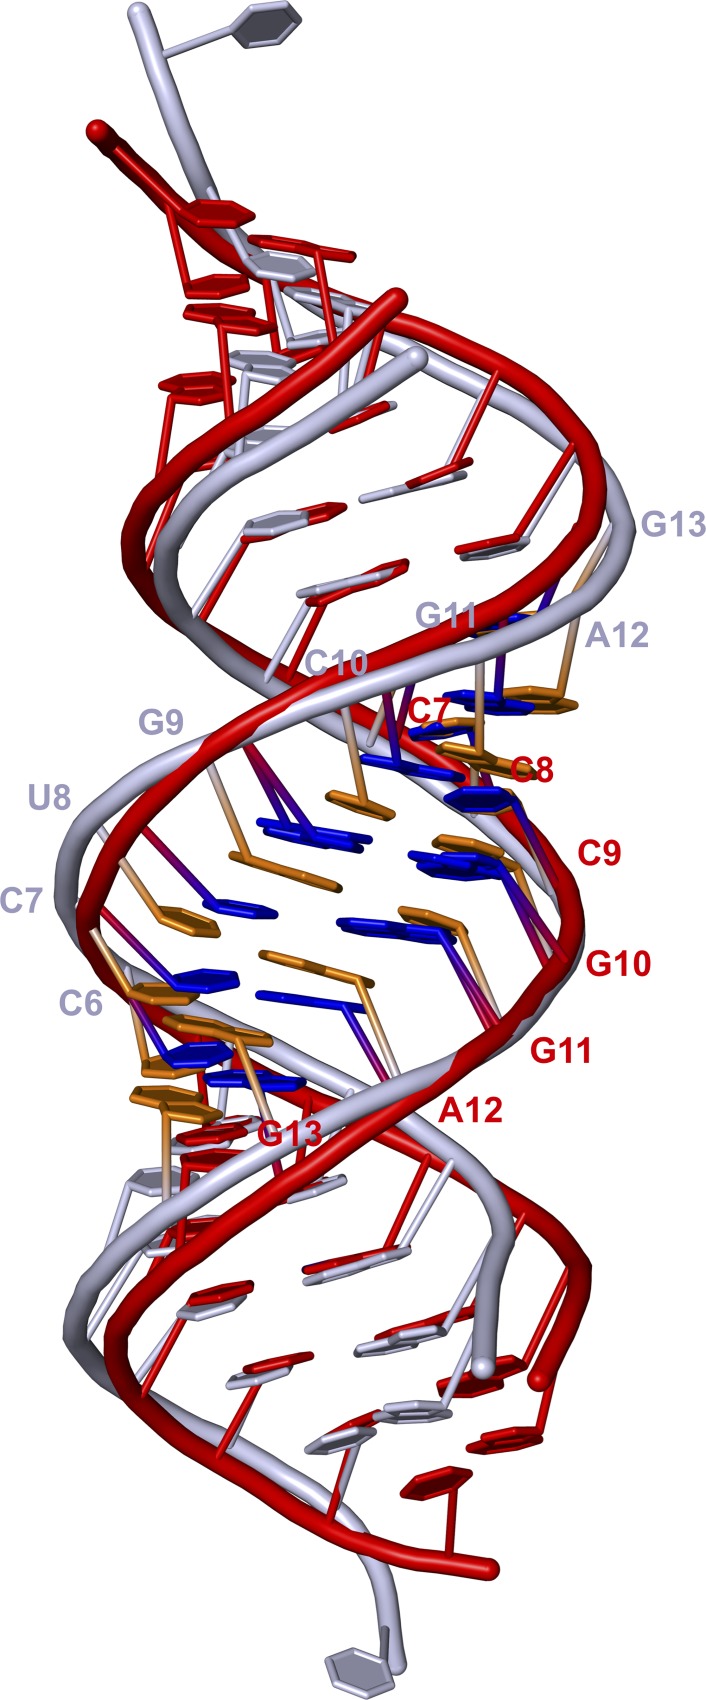
Superposition of the RNA II and 1KFO structures.RNA II (red) duplex structure with one CC(N)2GAG motif marked (bases in blue). 1KFO (gray) crystallographic duplex with one CC(N)3GAG motif marked (bases in orange).